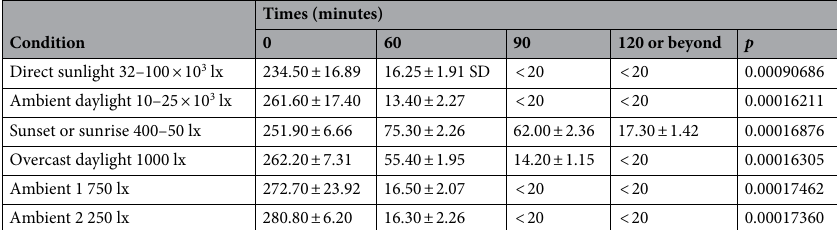
Table 2. Performance of the WIWELL TiO 2 –Ag–NP photocatalytic film upon different light sources.